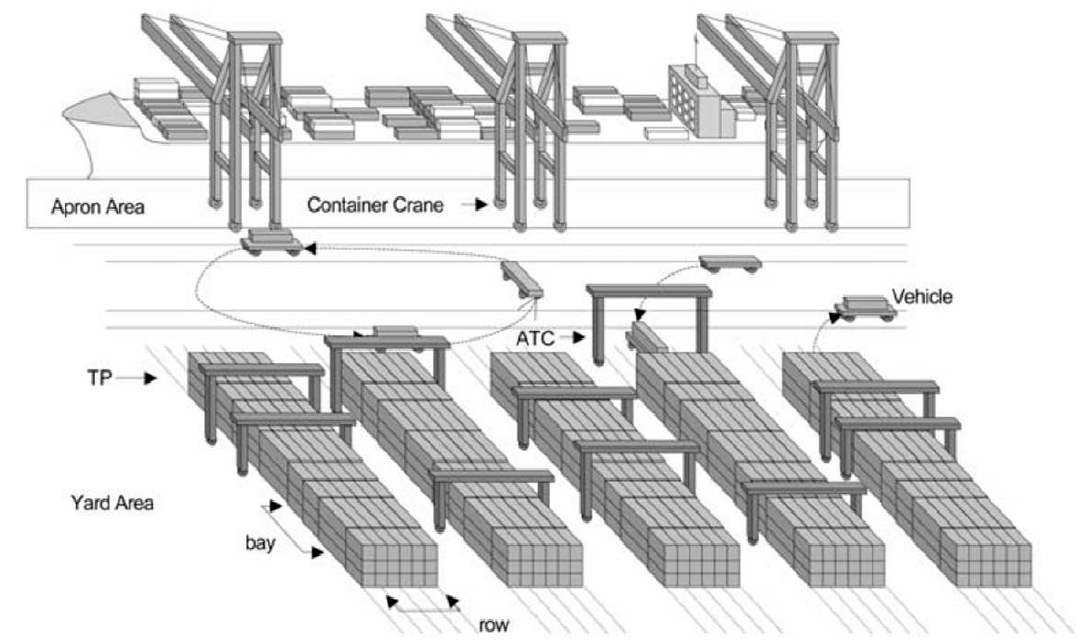
Figure 3. Modern container terminal.